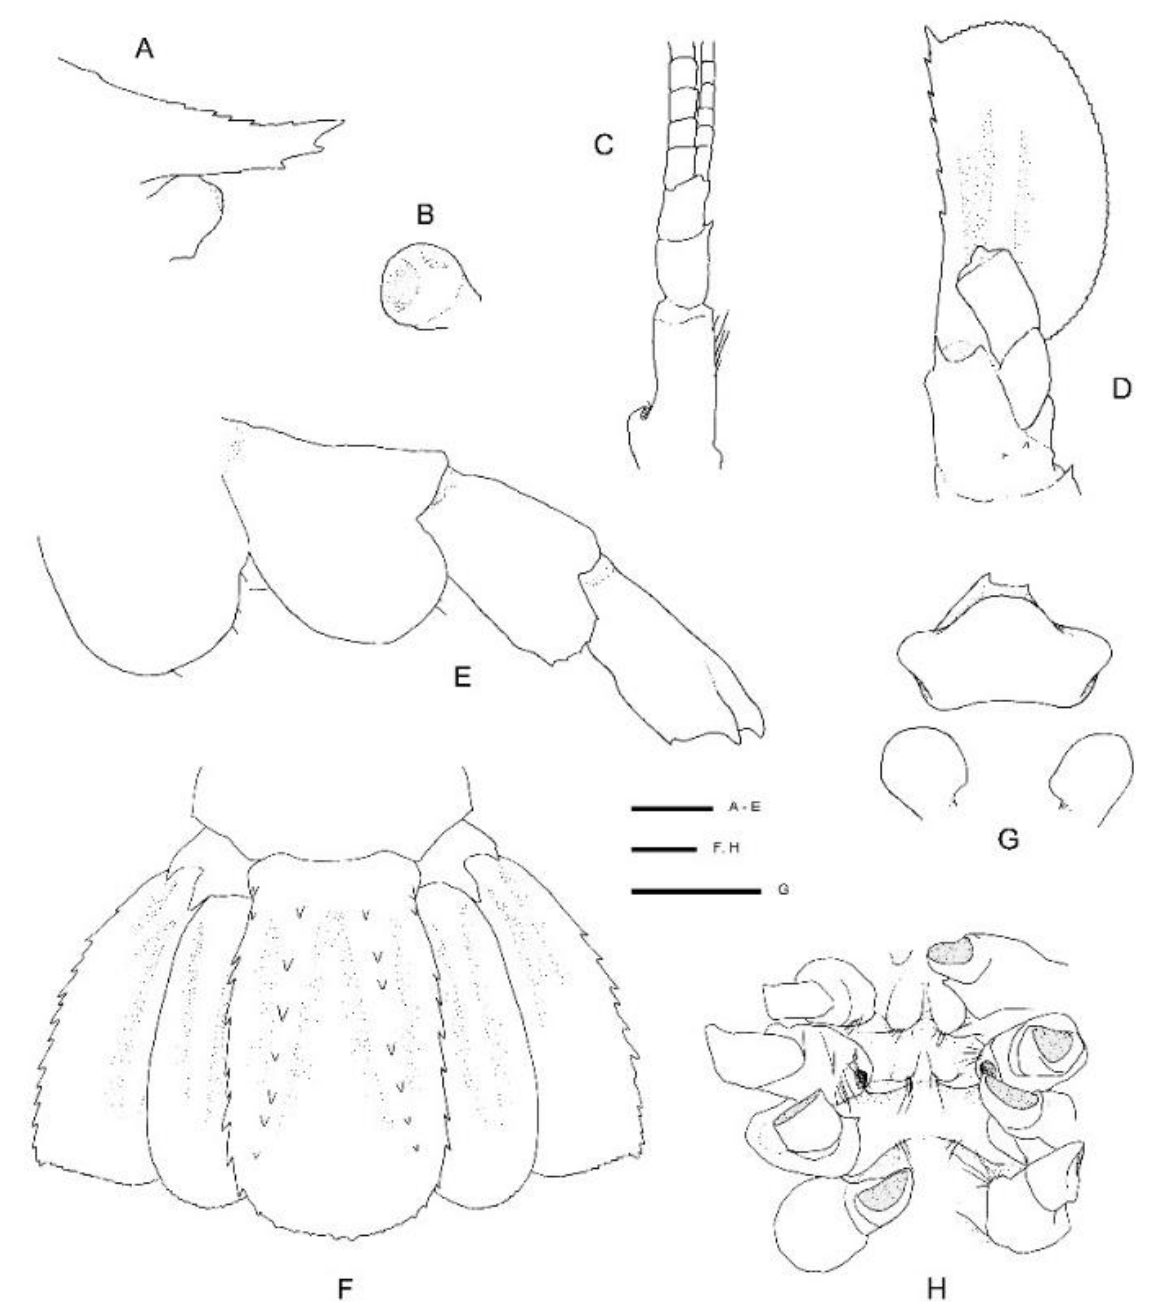
Figure 9. Spongicoloides novaezelandiae Baba, 1979 [20], F (NIWA 40567). ( A ) Rostrum, lateral. ( B ) Left eye, outer view. ( C ) Left antennule, dorsal. ( D ) Left antennal scale, dorsal. ( E ) Third to sixth pleura, lateral. ( F ) Telson and uropods, dorsal. ( G ) Epistome, labrum and paragnaths, ventral. ( H ) Thoracic sternites, ventral. Scale bars = 1 mm.